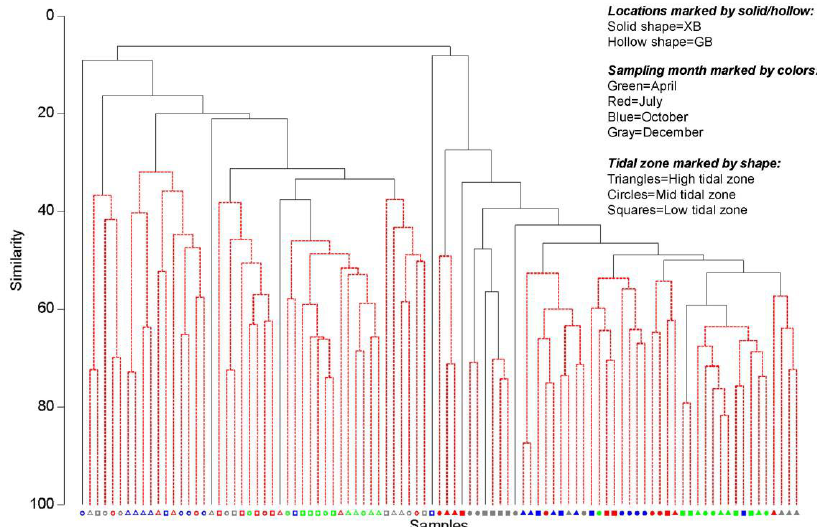
Figure 3. Cluster analysis of the nematode community. Nematode species data were standardized and fourth root transformed, SIMPROF analysis at 5% significance level.